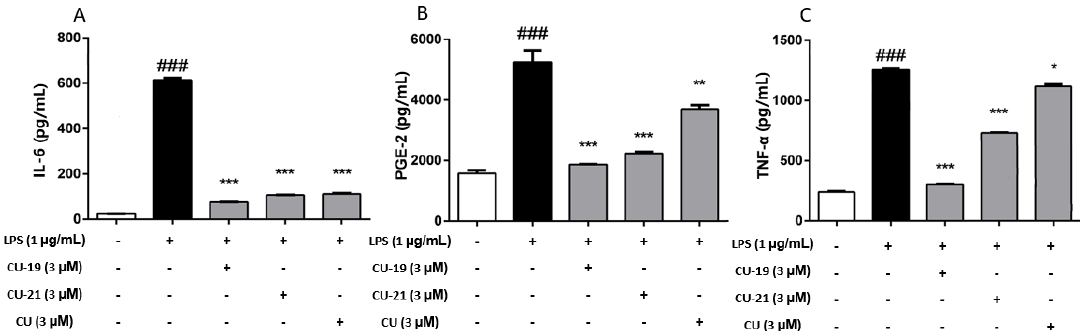
Figure 3. The ability of CU-19 , CU-21 and CU to inhibit LPS-induced ( A ) IL-6, ( B ) PEG-2, ( C ) TNF- α release in BV2 cells. BV2 cells were pretreated with CU-19 , CU-21 and CU (3 µM) for 1 h and then stimulated with LPS (1 μg/mL) for 24 h. Results were the mean ± SD, n = 3; ### p < 0.001 vs. control; * p < 0.05; ** p < 0.01; *** p < 0.001 vs. LPS